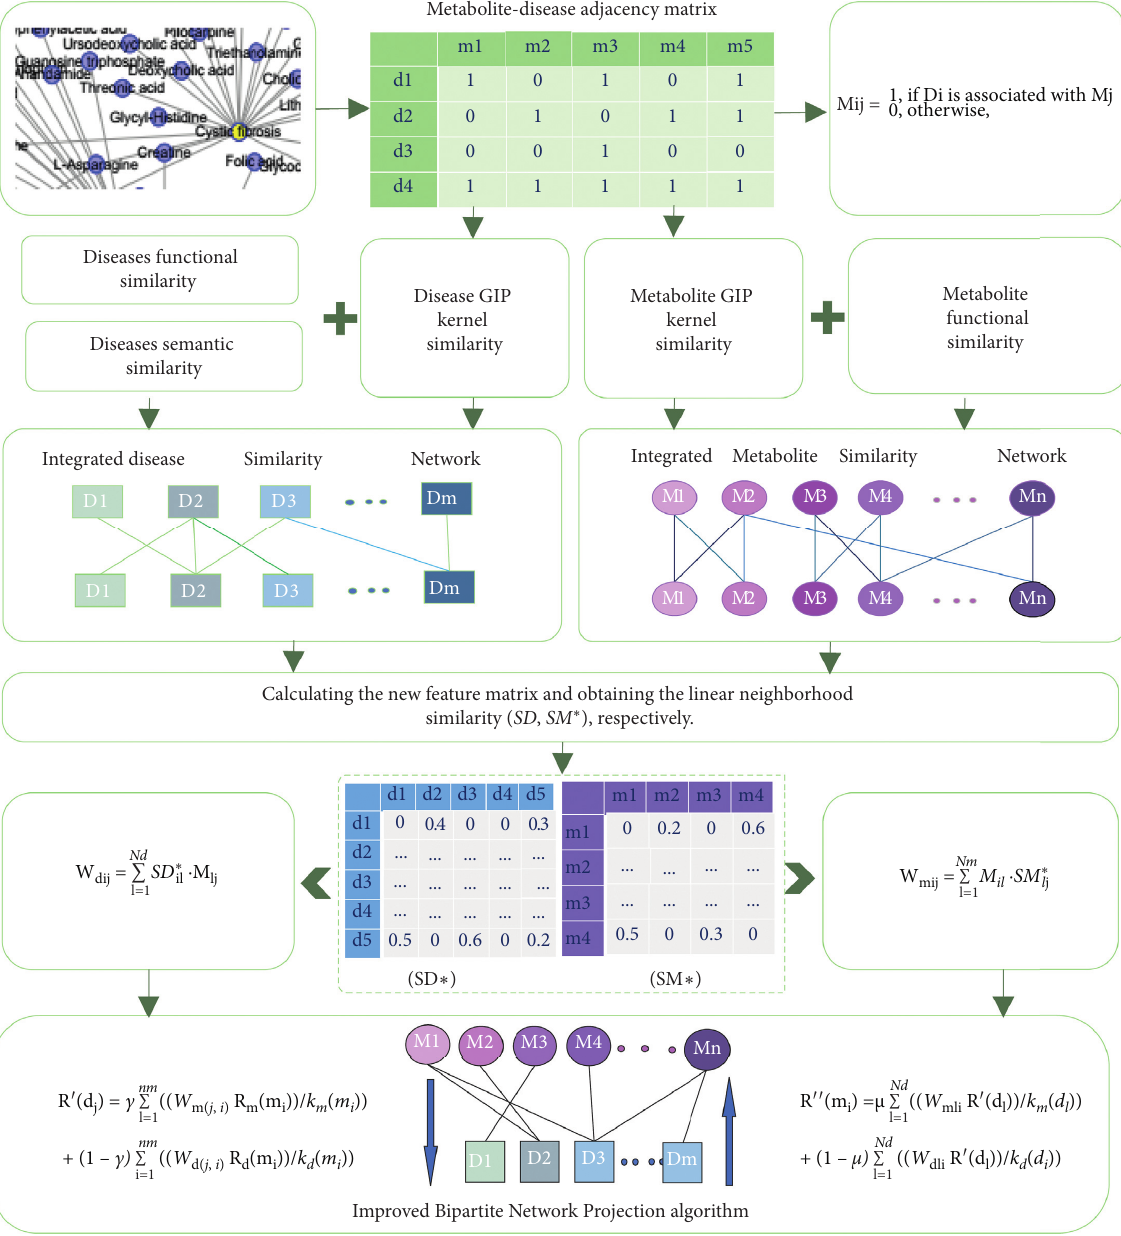
Figure 1: Flowchart of